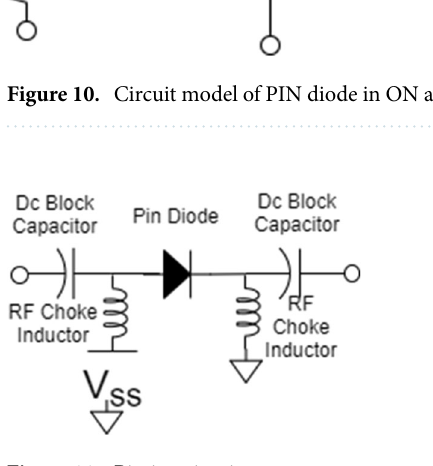
Figure 11. Biasing circuit.